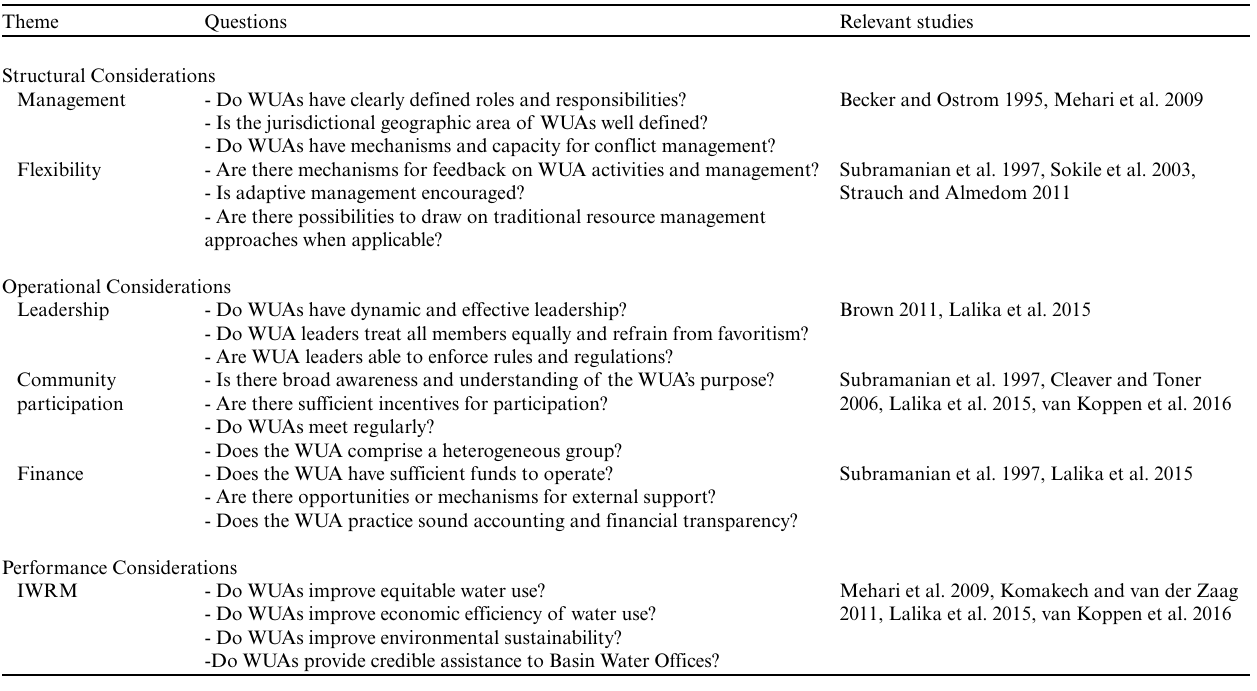
Table 1. Sustainability considerations for participatory water users’ associations (WUAs), based on factors identified by existing studies to affect functioning of